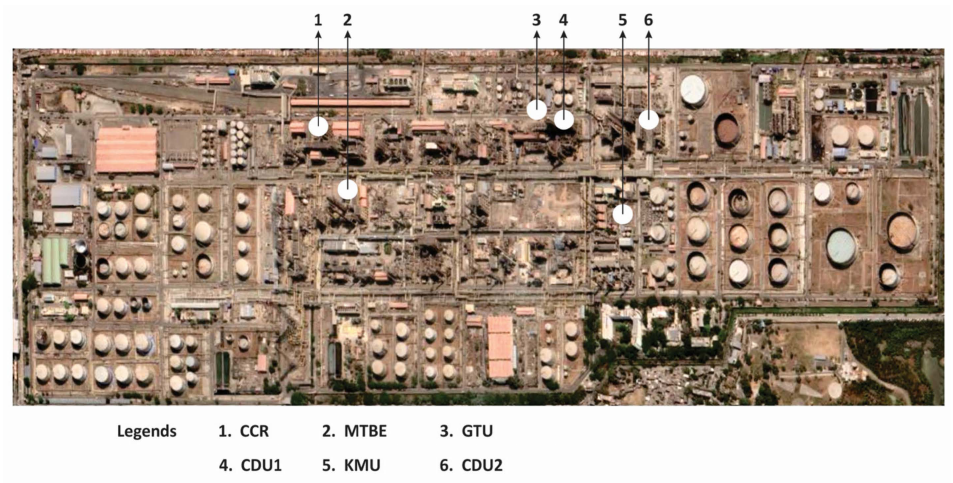
Figure 2. Satellite image of a petroleum refinery.